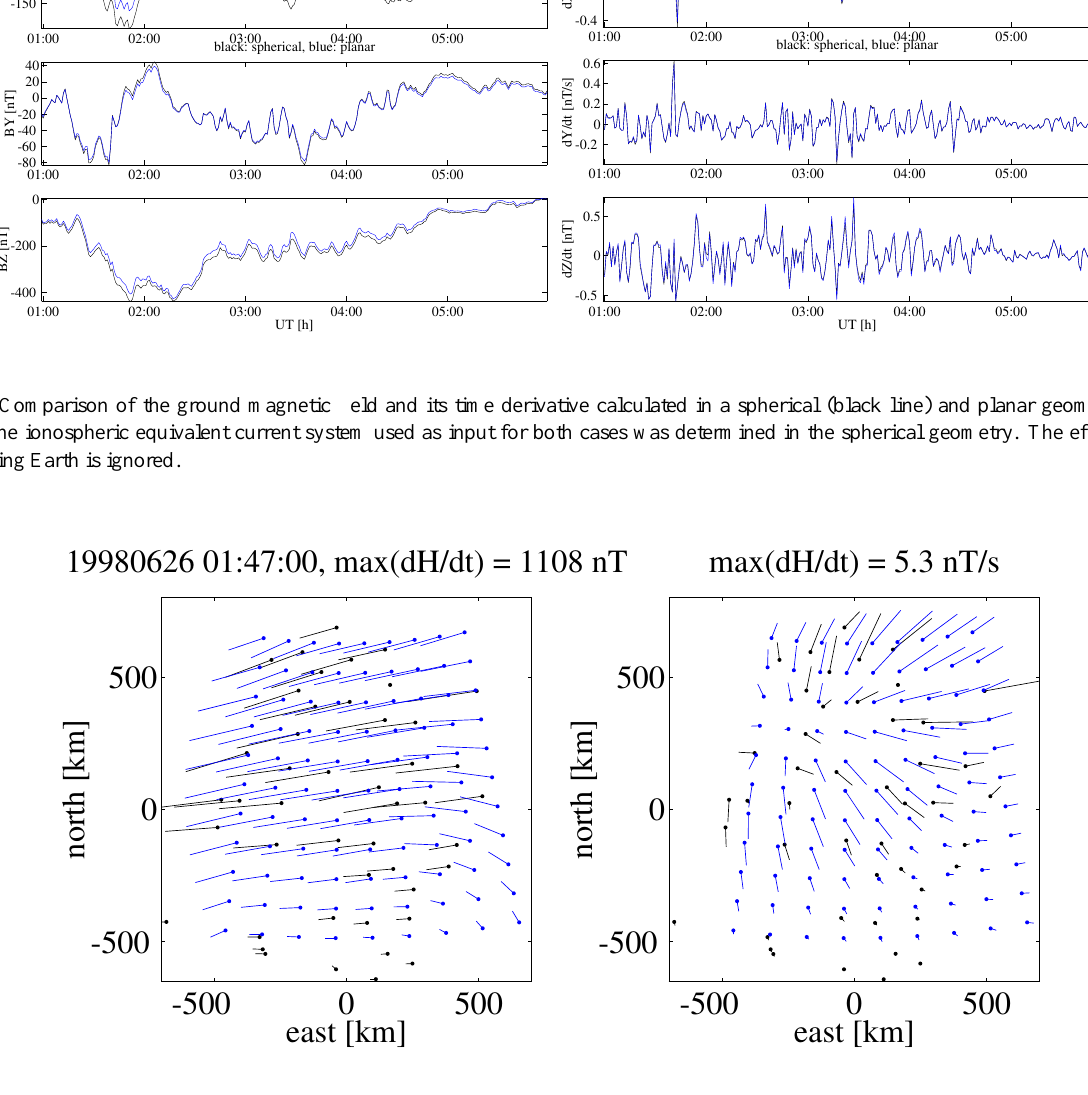
Fig. 3. Measured and modelled horizontal magnetic field in the BEAR region on 26 June 1998, 01:47 UT. Left panel: horizontal magnetic field vectors (rotated 90 degrees clockwise). Right panel: time derivative of the horizontal magnetic field. Measured values are shown with black arrows and modelled with blue arrows. The effect of the conducting Earth is ignored. Only IMAGE magnetometer were used to derive ionospheric equivalent currents.